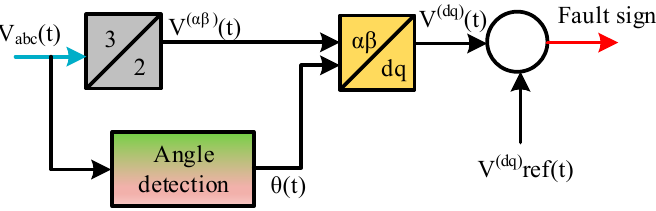
Figure 3. Topology for fault detection in solid-state transfer switch (SSTS) [18].